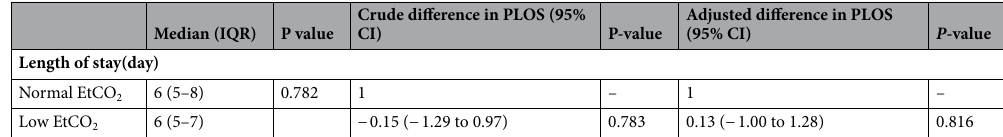
Table 4. Multivariable analysis of the relationship between EtCO 2 and PLOS. EtCO 2 end-tidal carbon dioxide, PLOS postoperative length of stay, IQR interquartile range, CI confidence interval.